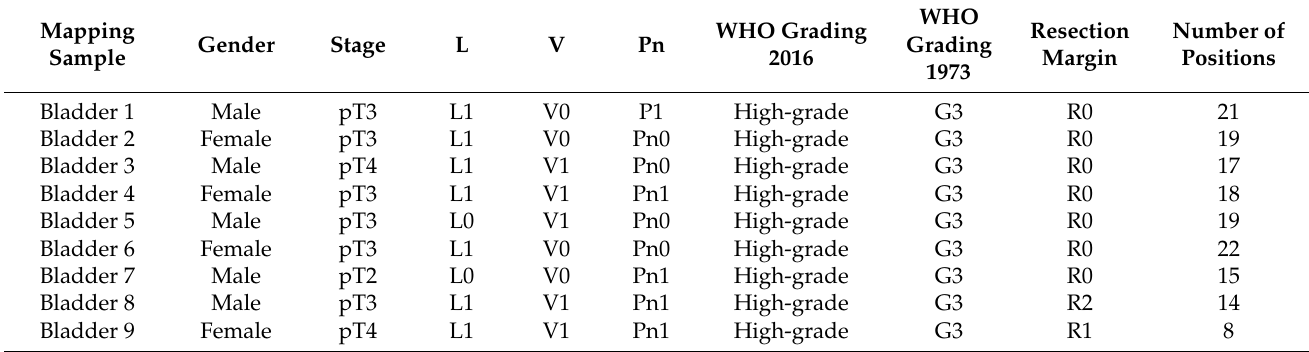
Table 1. Study characteristics of the whole-organ mapping bladder cancer specimens.